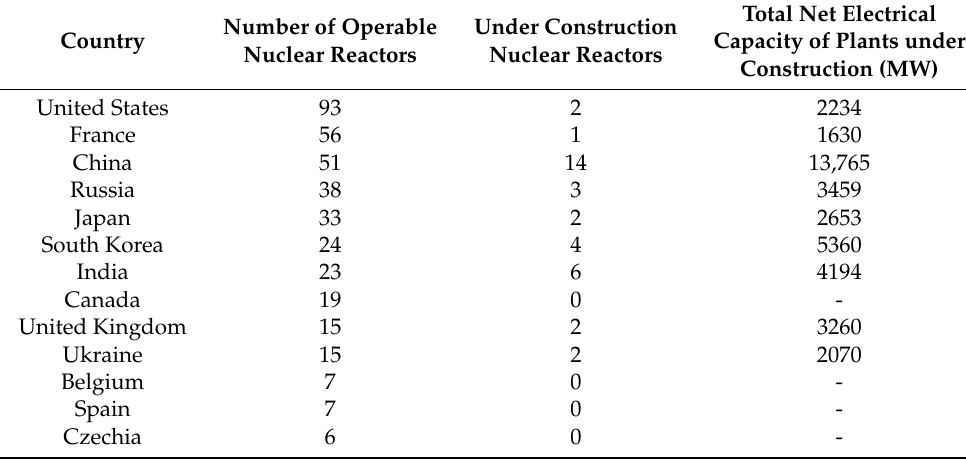
Table 2. Status of Nuclear power reactors. Data source: Asian Development Bank. Number of Operable Under Country